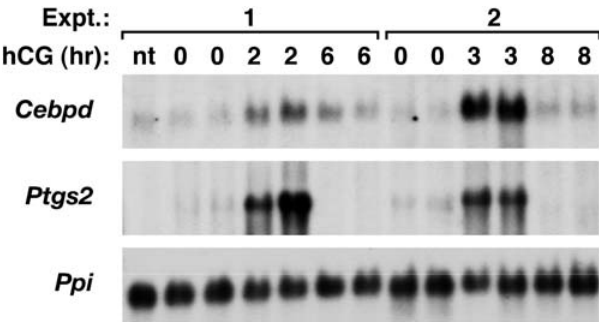
Figure 1. Cebpd mRNA expression is induced by hCG in mouse ovaries. Northern blot analysis of whole ovary total RNA isolated from 5 week-old (Exp.1) or 3 week-old (Exp.2) mice treated for 2 days with PMSG followed by the LH analog hCG for the indicated times (n.t.=no treatment). Ptgs2 was used as a positive control for the hCG response. Cyclophilin ( Ppi ) was used as loading control.